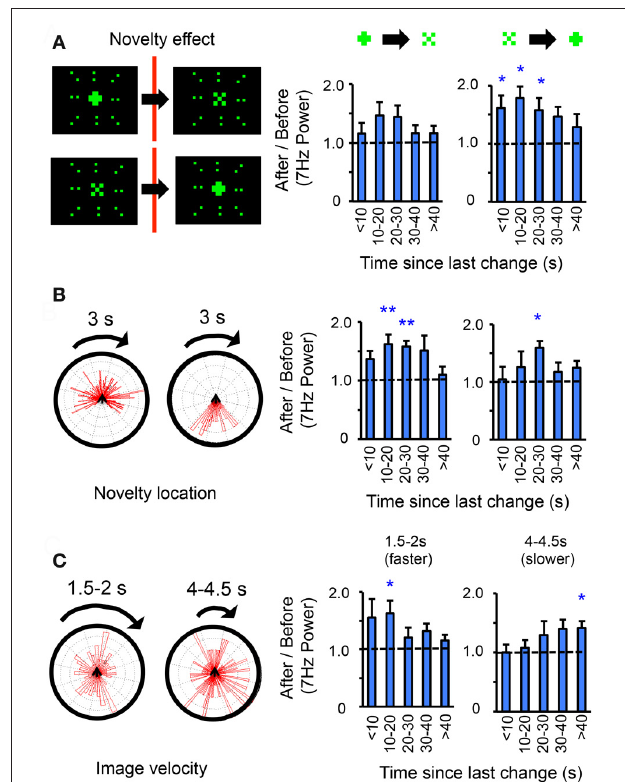
FIGURE 4 | Object shape, novelty location, and image velocity modulate visual salience effects. (A) Left panels: Novelty could either be from a “ + ” to an “ × ” or vice versa. The size of either 7Hz object is identical (30 ◦ square, 20 pixels), the surrounding 9Hz display never changes. Right panels: the same data as in Figure 3G , partitioned into either transition sequence (indicated above the histograms). n = 12 flies, ∗ P < 0 . 05, by t- test compared to 1.0 (dashed line). Only 7Hz effects are shown. (B) Effect of novelty location/timing. Left panels: the same data as in A was divided according to where in the rotation sequence changes occurred (in front of the fly, left rose plot; behind, right rose plot), and 7Hz power ratios (3s after/3s before) recalculated for each situation (right panels), n = 12 flies, P < 0 . 05, ∗∗ P < 0 . 01, by t- test compared to 1.0 (dashed line). (C) 7Hz ratios (3s after/3s before) for a faster moving pattern with a period of 1.5–2s, or a slower moving pattern with a period of 4–4.5s. n = 9 flies, ∗ P < 0 . 05, by t- test compared to 1.0 (dashed line). Rose plots on left indicate positions where changes occurred for either set of